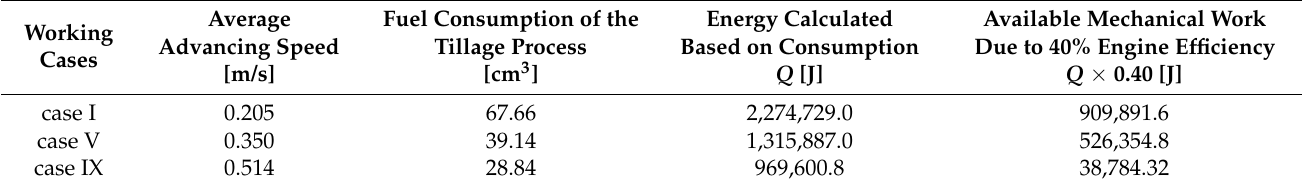
Table 4. Measured and derived working parameters for 15 m soil tillage (extract from [8]).